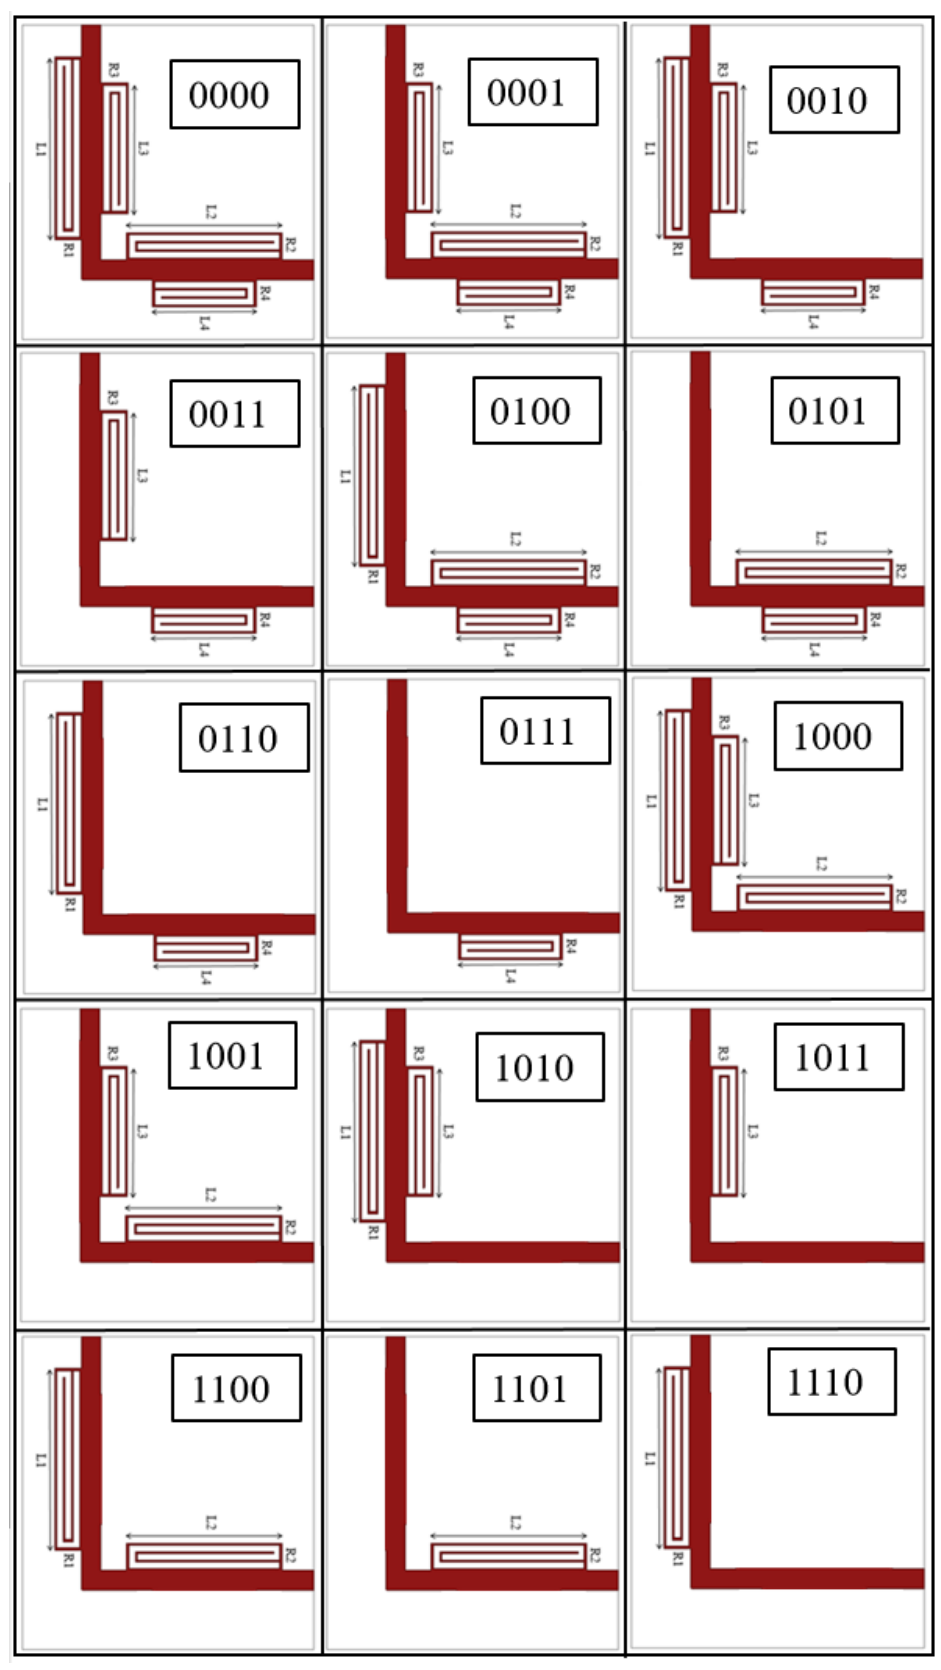
Figure 6. Resonators configurations for a 4 bits chipless